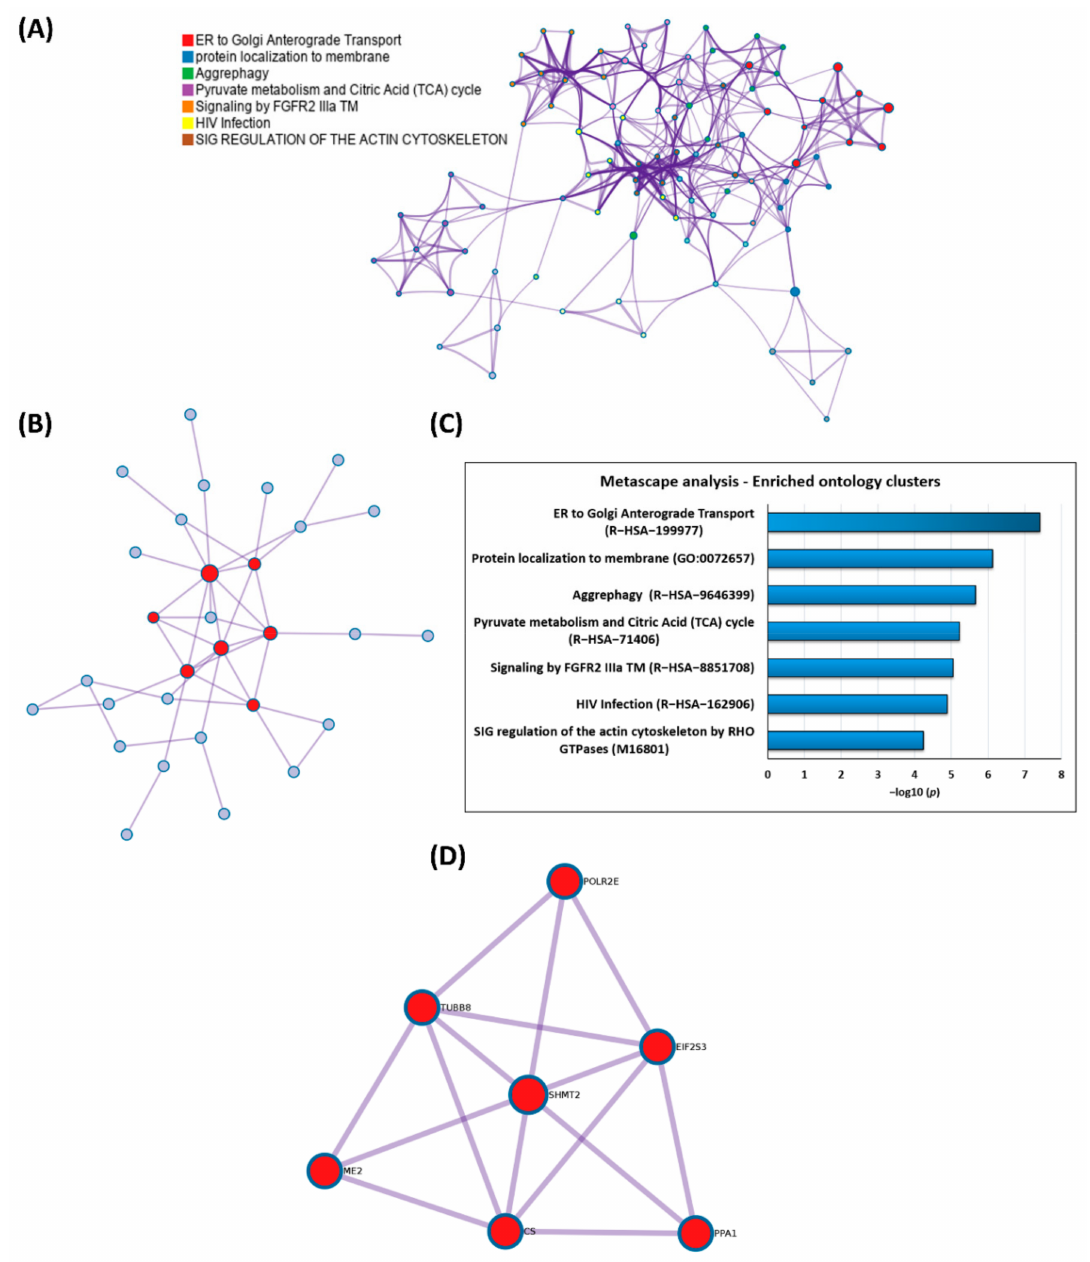
Figure 5. Metascape analysis of the identified protein interaction partners of HTRA2. ( A ) The seven most significant protein interaction pathways identified by enriched GO and Reactome terms colored by cluster. ( B ) The seven most significant protein interaction pathways with the corresponding − log 10 -adjusted p values. ( C ) Protein − protein interaction (PPI) networks with densely connected components (red) identified by the molecular complex detection (MCODE) algorithm. ( D ) Magnified view of the significant PPI network comprising the HTRA2-specific interactors POLR2E, TUBB8, SHMT2, EIF2S3, ME2, CS, and